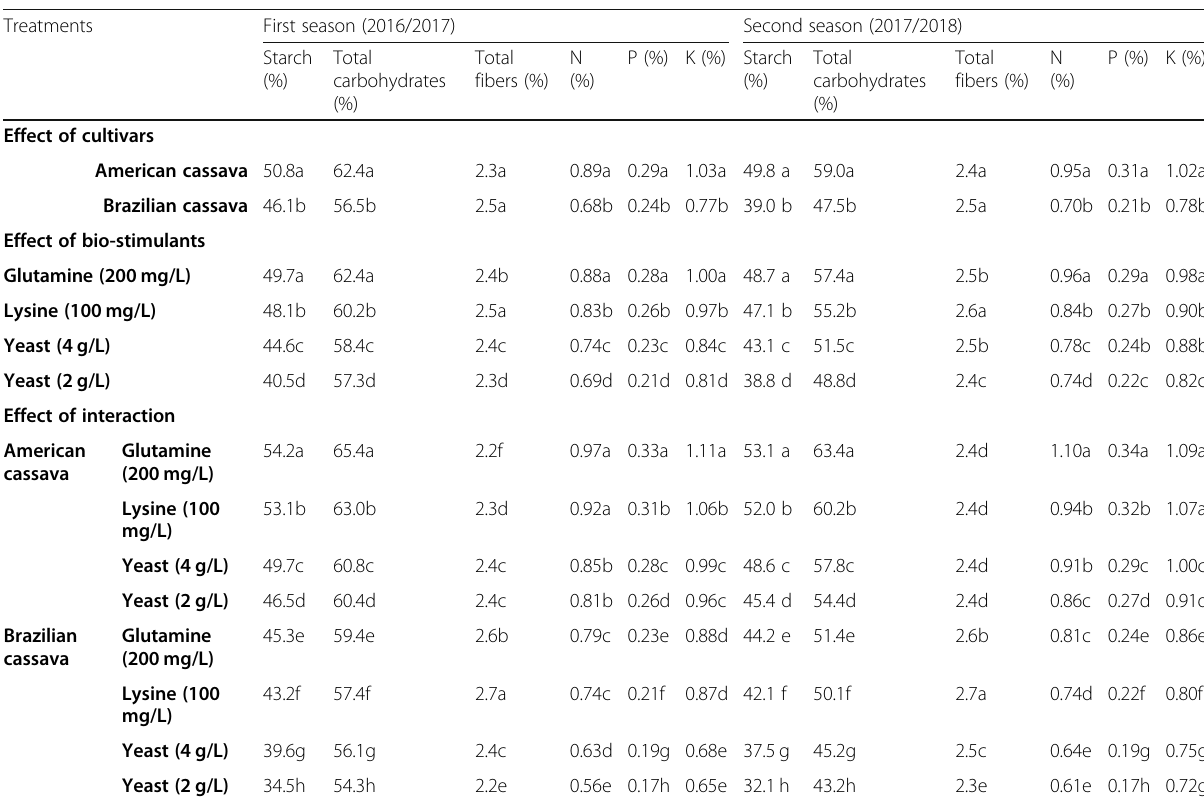
Table 3 Effect of different bio-stimulants on chemical contents of tuber roots of Cassava cultivars in 2016/2017 and 2017/2018